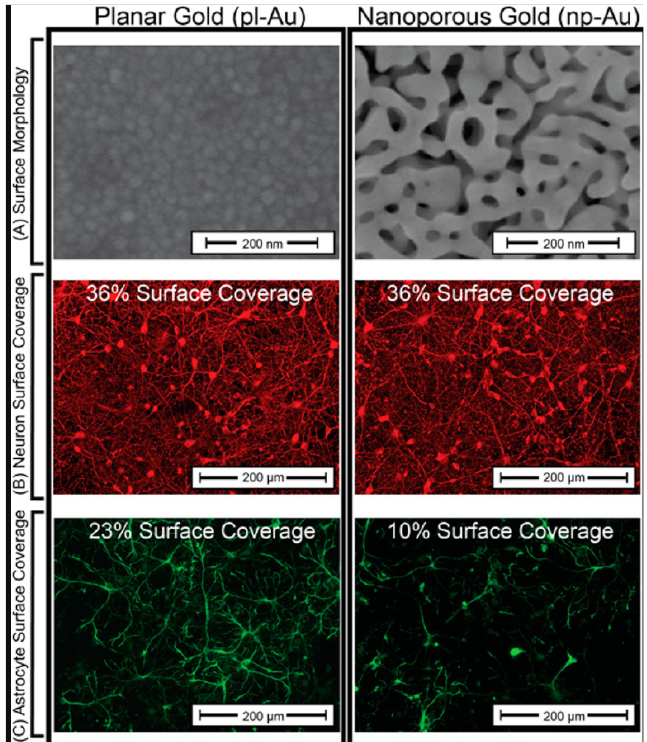
Figure 1. ( A ) Scanning electron micrographs of pl-Au and np-Au show marked differences in surface morphology. ( B ) Fluorescent images of β -tubulin immunopositive cells (red) show high neuron coverage on both pl-Au and np-Au. ( C ) Fluorescent images of GFAP immunopositive cells (green) indicate astrocyte coverage on np-Au that is significantly reduced compared to pl-Au. Numerical values of the cell surface coverage are provided for quantitative comparison of the fluorescent images. Reprinted with permission from ref. [2] Copyright 2017, American Chemical Society.